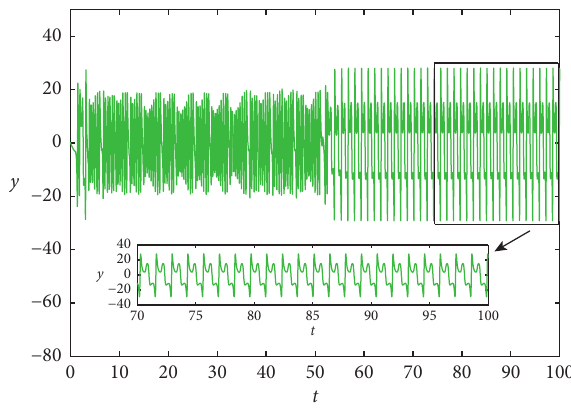
Figure 7: Waveform plot of system (7) near ( d , τ ) � (− 2 . 902 , 0 . 344 ) with parameters ( μ 0 0 0 . 1664 ) , τ � 0 . 5104, tspan � [ 0 , 100 ] , and ( x